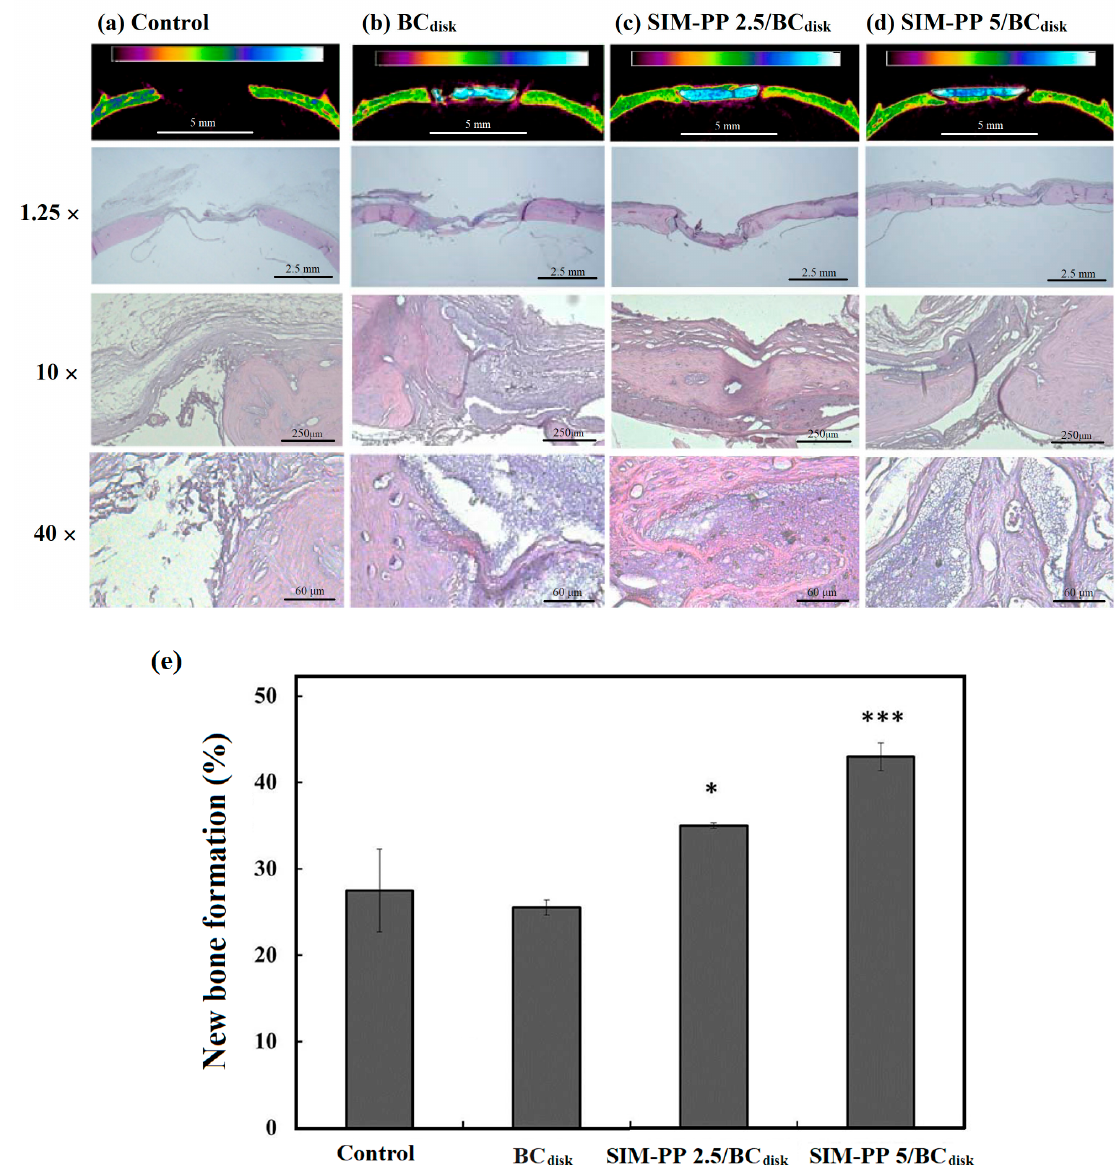
Figure 4. Typical Hounsfield unit (HU) calibration of micro-CT images and histological study of calvarial bone defects in the rat model only ( a ) and 8 weeks after implantation of BC disk ( φ 5 mm; h 0.7 mm) ( b ), 2.5 µ mol of SIM in SIM-PP/BC disk ( c ), or 5.0 µ mol of SIM in SIM-PP/BC disk ( d ). Callus quantification study of these calvarial bone defects groups ( e ). Notes: Non-union defects implanted without bone graft substitutes were used as controls; N = 5/group. * p < 0.05 and *** p < 0.001 compare control.